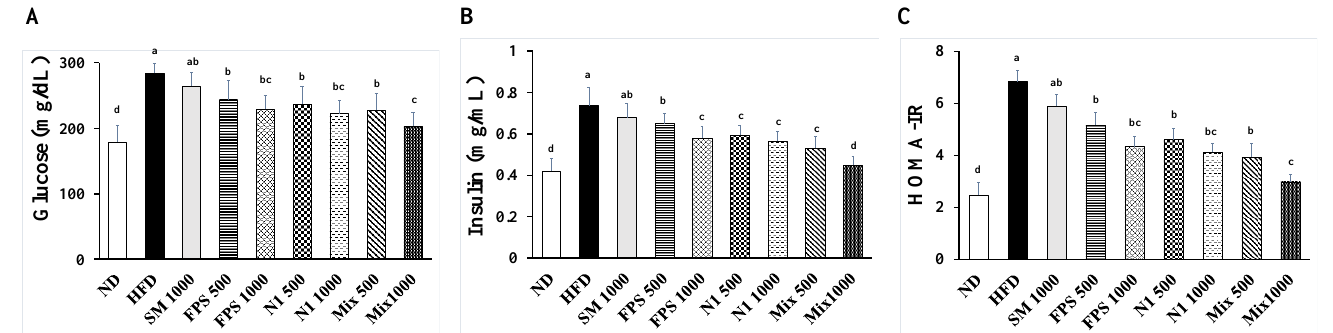
Figure 3. The impact of fermented SBM on fasting plasma glucose parameters. The rats were fed a HFD for 10 weeks, followed by various fermented SBM products for 6 weeks. The blood samples were individually collected after fasting for 12 h to determine the concentrations of ( A ) glucose and ( B ) insulin in plasma, and to calculate the ( C ) homeostasis model assessment equation-insulin re- sistance (HOMA-IR) value. Results are expressed as a mean ± standard deviation for each group of rats ( n = 8). Different letters (a – e) indicate the statistical difference ( p < 0.05) between each group .